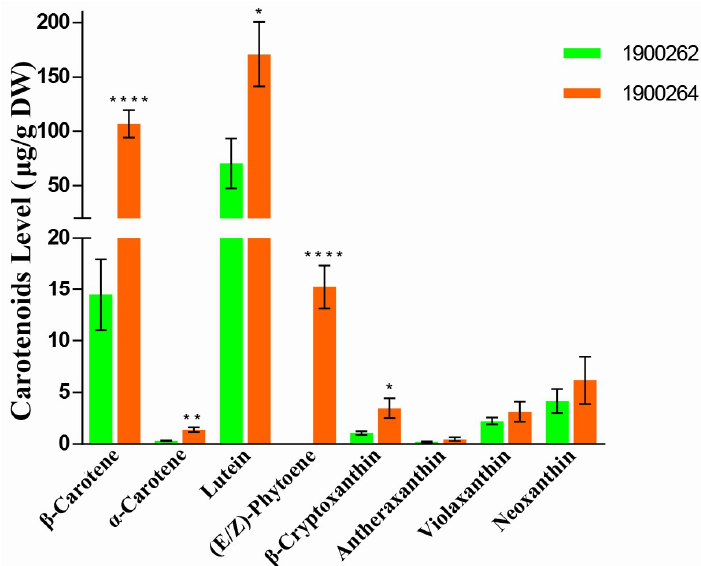
Figure 3. Comparison of carotenoid content in the inner leaves of the ‘1900262′ and ‘1900264′ lines. Data are the average ± SE of three biological replicates. Asterisk (*) indicates that there is a statistical difference, * indicates p ≤ 0.05; ** indicates p ≤ 0.01; **** indicates p ≤ 0.0001.